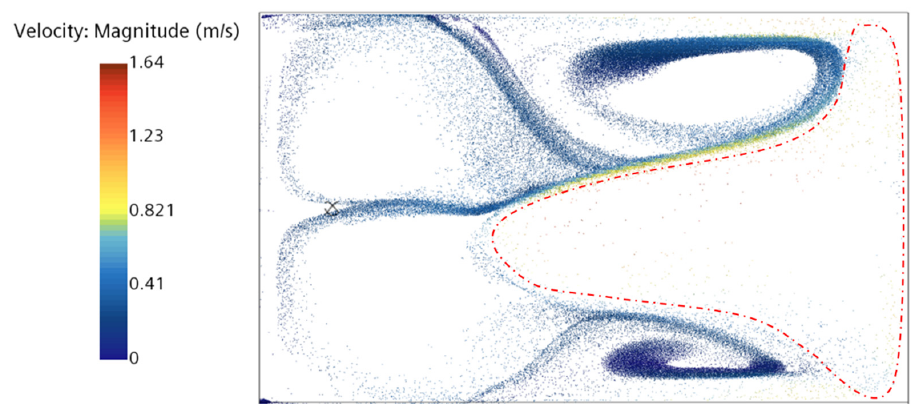
Figure 20. Location and velocity distribution of particles in the region of 5 mm from the bottom of pool.